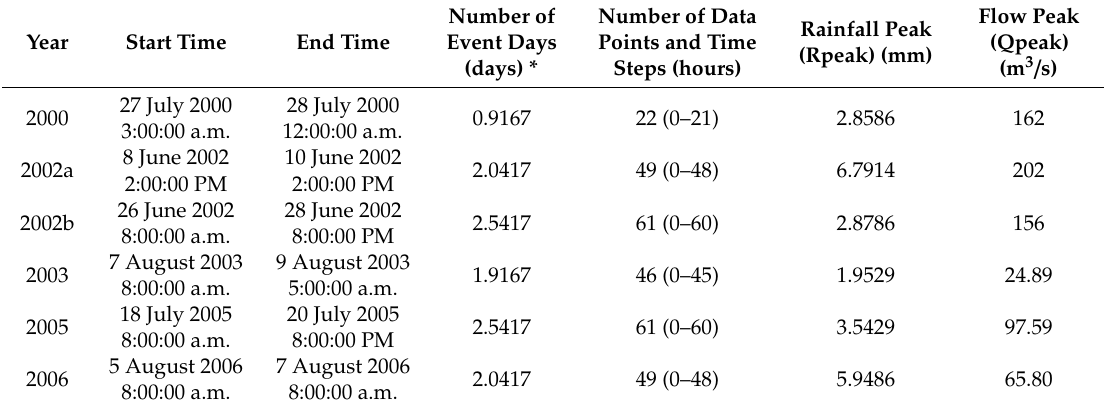
Table 1. Observed statistics of the periods of the selected flood events of the Zhidan